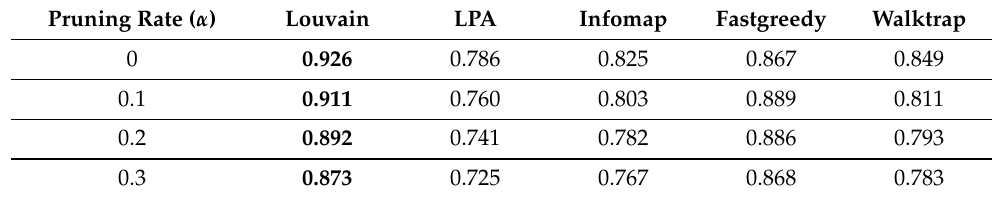
Table 4. Modularity values of clustering algorithms with various link pruning rates. Pruning Rate ( α ) Louvain LPA Infomap Fastgreedy Walktrap 0 0.926 0.786 0.825 0.867 0.849 0.1 0.911 0.760 0.803 0.889 0.2 0.892